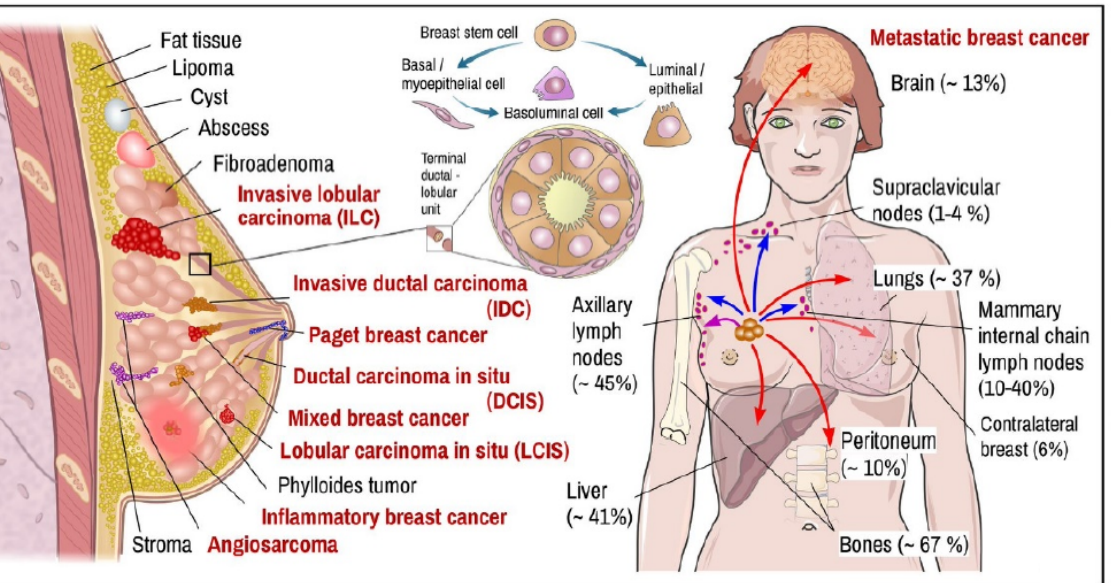
Figure 1. BC in women. Histological and molecular characterizations have significant effects on the treatment procedures. Left: the main histopathological BC types (red) and other important pathobiological findings. Middle: ductal-lobular terminal unit showing the location of basal-myoepithelial cells and luminal cells. Right: locations that are frequently involved in BC metastasis. Arrows indicate the locations of metastatic spread in the body: violet—local, blue—through lymph, and red—via blood. Reprinted by permission from Pubmed. NCBI, ref. [29], copyright 2022.